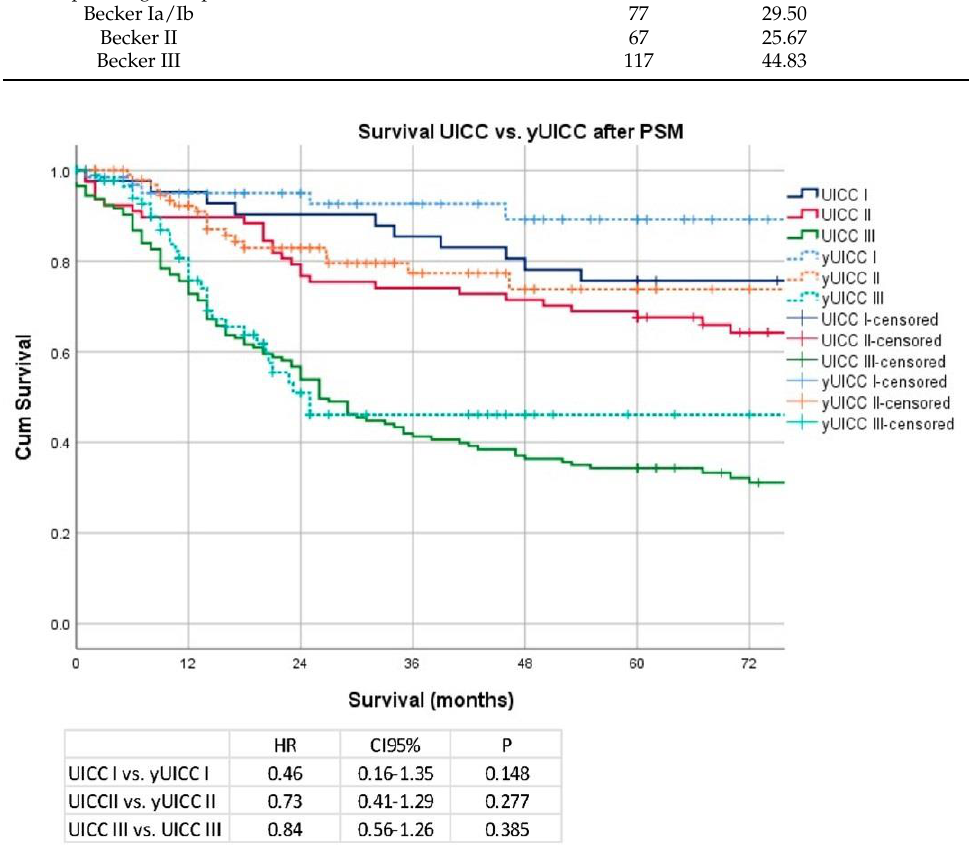
Figure 4. Kaplan–Meier analyses according to UICC/yUICC stages after Figure 4. Kaplan – Meier analyses according to UICC/yUICC stages after PSM. Regarding the pT/ypT stages, there was no significant difference for stage pT1 vs. ypT1 (median OS 149 months vs. not reached; HR 0.17; CI 95% 0.02 – 1.47; p = 0.07), pT2/ypT2 (median OS 109 months vs. not reached; HR 0.64; CI 95% 0.25 – 1.68; p = 0.36), pT3 and ypT3 (48 vs. 91 months; HR 0.68; CI 95% 0.45 – 1.03; p = 0.06), and pT4/ypT4 (me- dian OS: 29 vs. 23 months; HR 0.74; CI 95% 0.40 – 1.36; p = 0.32). Data are shown in Figure 5. Regarding pN/ypN stages, a significant survival difference was demonstrated only for pN2/ypN2 stage (median OS 38 months vs. not reached; HR 0.40; 0.17 – 0.96; p = 0.03), but no significant differences were detectable for patients without pathological lymph node involvement pN0/ypN0 (median OS 177 months vs. not reached; HR 0.60; CI 95% 0.31 – 1.20; p = 0.15) or other pN stages (pN1/ypN1 (median OS: 92 months vs. not reached, HR 0.69; CI 95% 0.35 – 1.38; p = 0.291) and for pN3/ypN3 stage (median OS 26 vs. 21 months; HR 1.26; CI 95% 0.77 – 2.08; p = 0.35)). Data are shown in Figure 6.